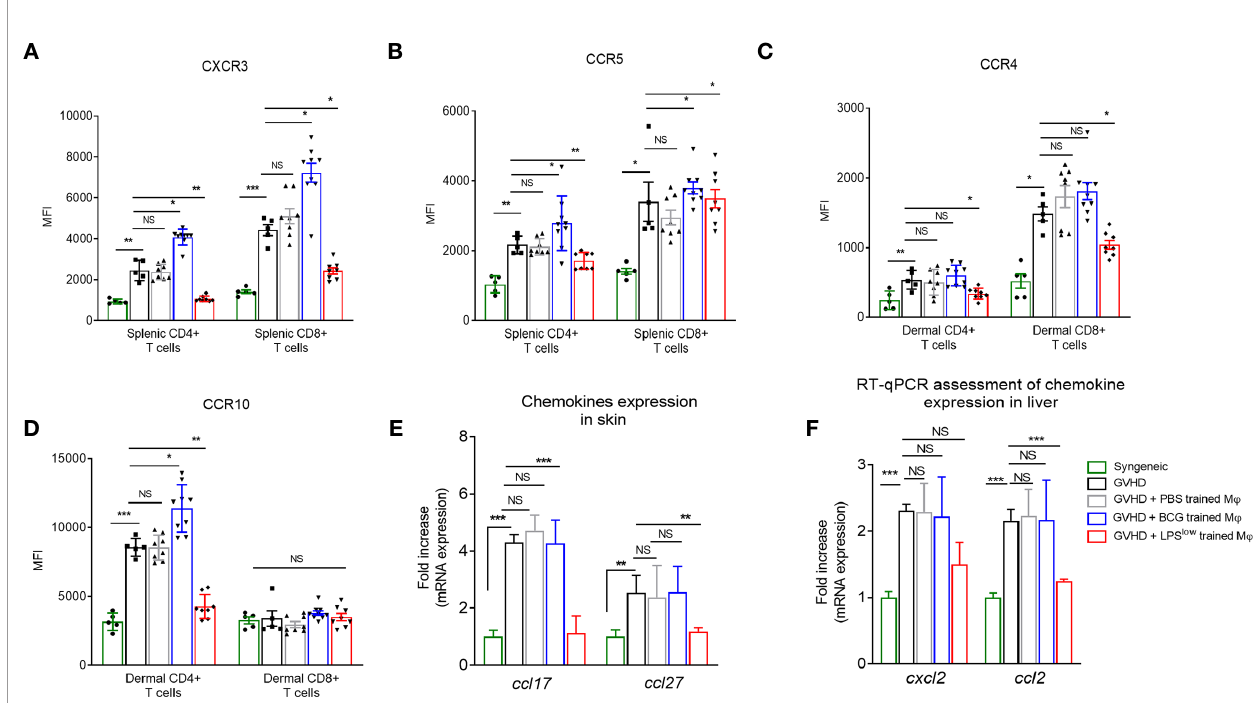
FIGURE 4 | LPS low -macrophage injections in fl uence the chemokine network in cGvHD mice. (A, B) Flow cytometric analysis of splenic CD4 + and CD8 + T-cells CXCR3 and CCR5 expression at day 40. (C, D) Flow cytometric analysis of dermal CD4 + and CD8 + T-cells CCR4 and CCR10 expression at day 40. Gating strategy is represented in Supplementary Figure S4 . Data represent the mean fl uorescence intensity of the chemokine receptors expression on T cells obtained from at least n = 7 biologically independent mice. The ANOVA test with Bonferroni correction was used to detect signi fi cant differences between the groups. NS, non- signi fi cant; *p ≤ 0.05; **p ≤ 0.01; ***p ≤ 0.001. (E, F) RT-qPCR assessment of c cl17 and c cl27 mRNA levels in the skin (E) and cxcl2 and ccl2 mRNA levels in the liver (F) of cGvHD mice at day 40 of the experiment. Results were expressed as fold increase versus the syngeneic group, derived from at least n = 7 biologically independent mice. Unpaired T-test was used to detect the signi fi cance between the groups. NS, non-signi fi cant; *p ≤ 0.05; **p ≤ 0.01; ***p ≤